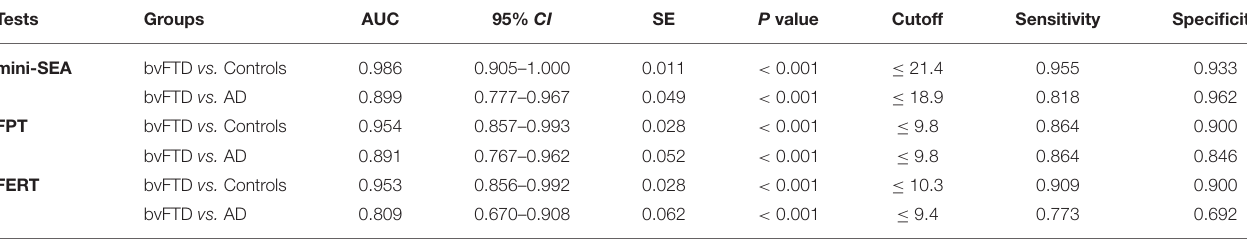
TABLE 3 | ROC analysis for Mini-SEA, FPT and FERT to discriminate the bvFTD group from the controls or AD group.